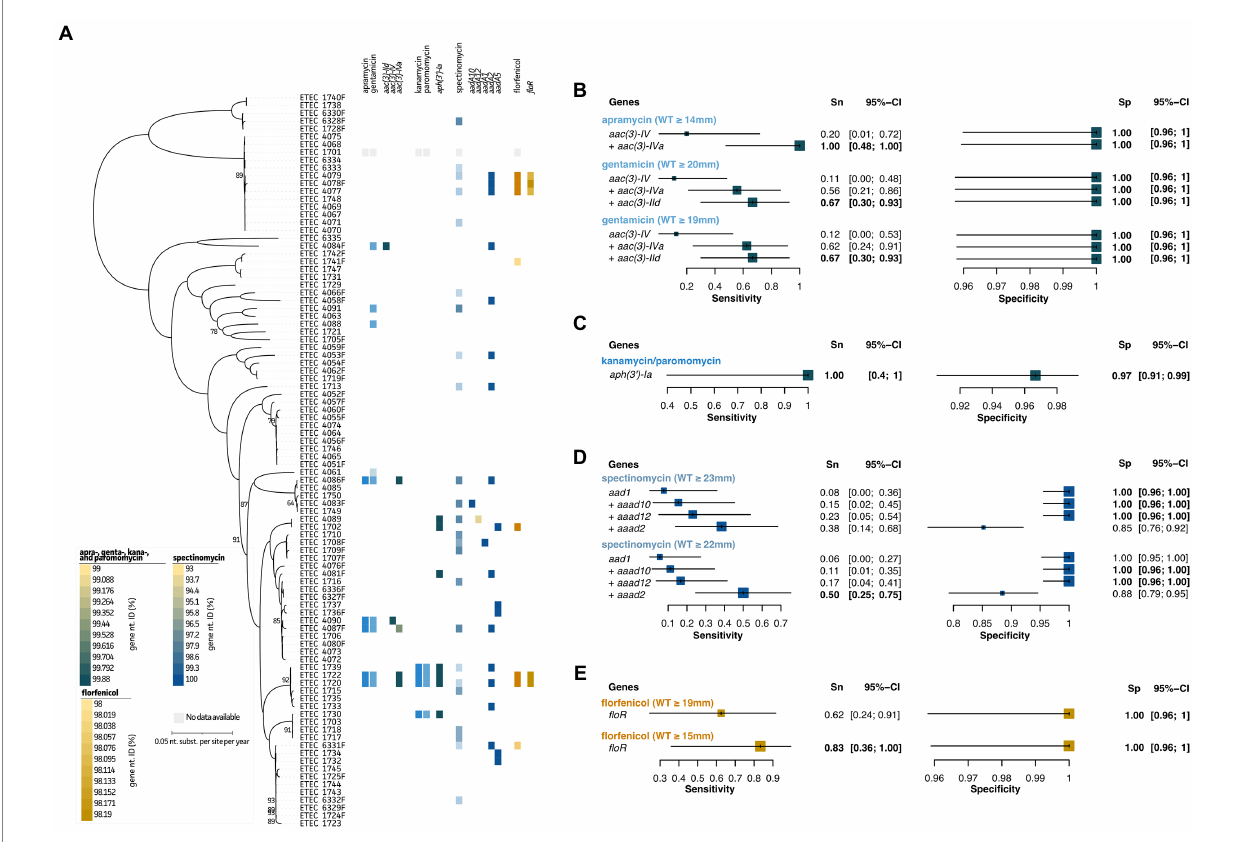
FIGURE 3 Association analyses for phenotypic and genotypic antimicrobial resistance of aminoglycosides and florfenicol. (A) Maximum Likelihood (ML) tree showing strain relatedness and distribution of resistance phenotypes and genetic markers. Resistance phenotypes are shown based on NRI ECOFF values in which white and colored boxes represent WT and non-WT population, respectively. From left to right; apramycin and gentamicin phenotypes, aac genes, kanamycin and paromomycin phenotypes, aph genes, spectinomycin phenotypes, aad genes, florfenicol phenotypes, and floR gene. Color grades for genes indicate nucleotide identities (%) as indicated in the legends at the left bottom. (B–E) Forest plots of predictive measures for selected genetic markers and ECOFF diameter cut-offs for the observed phenotypes (disc diffusion diameters (mm) or μ g.mL − 1 for colistin only). Forest plots show Sensitivity (Sn) and Specificity (Sp) measures and their 95% confidence intervals (CI). Whenever a “+” is indicated, the genetic marker was added to generate the confusion matrix for the